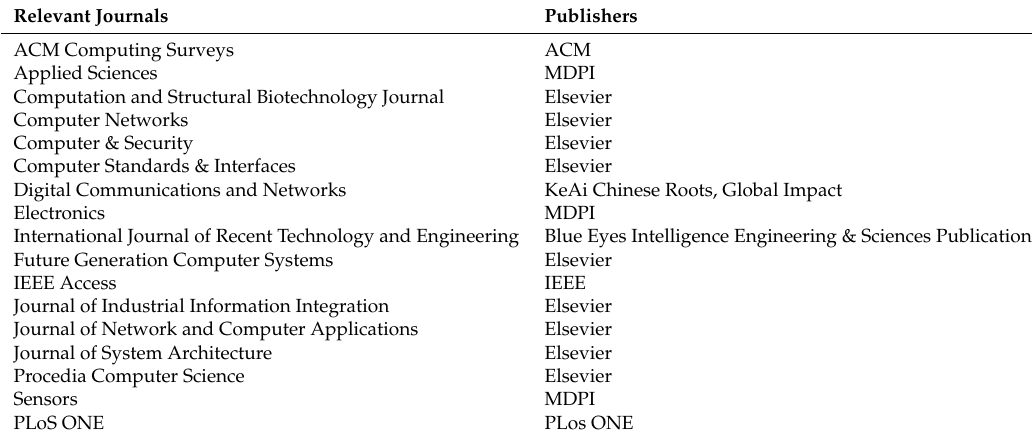
Table 2. Relevant journals and publishers.